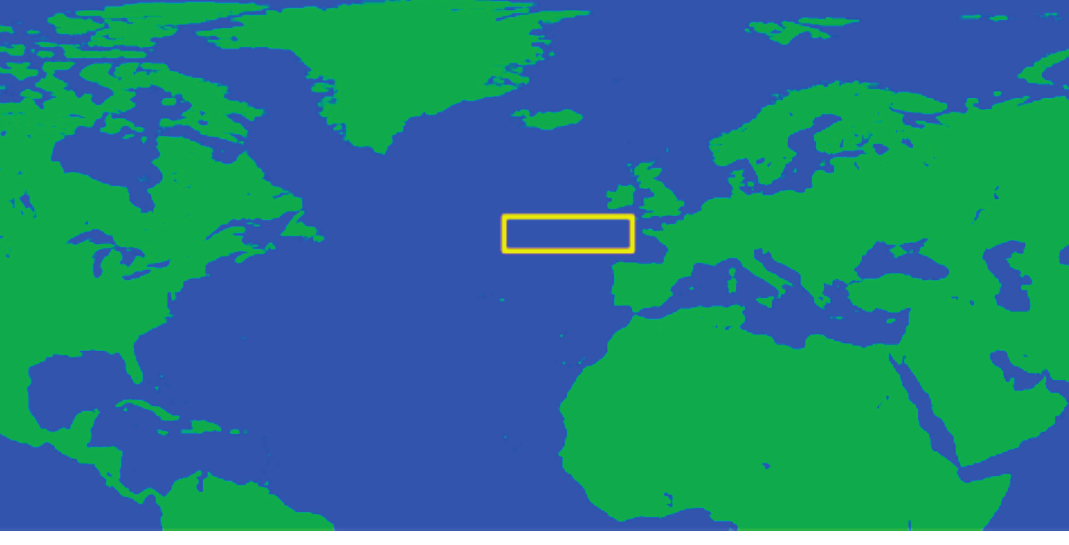
Figure 2. Map highlighting the study area used in this